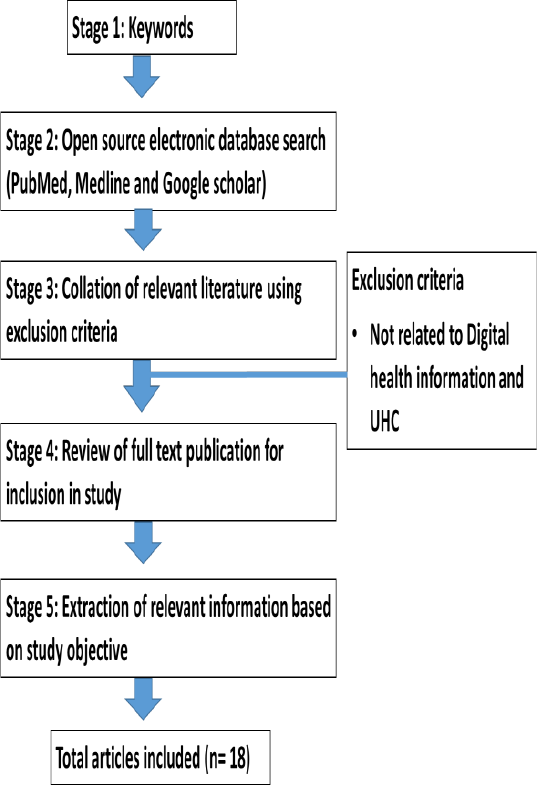
Figure 1: Stages of the literature search